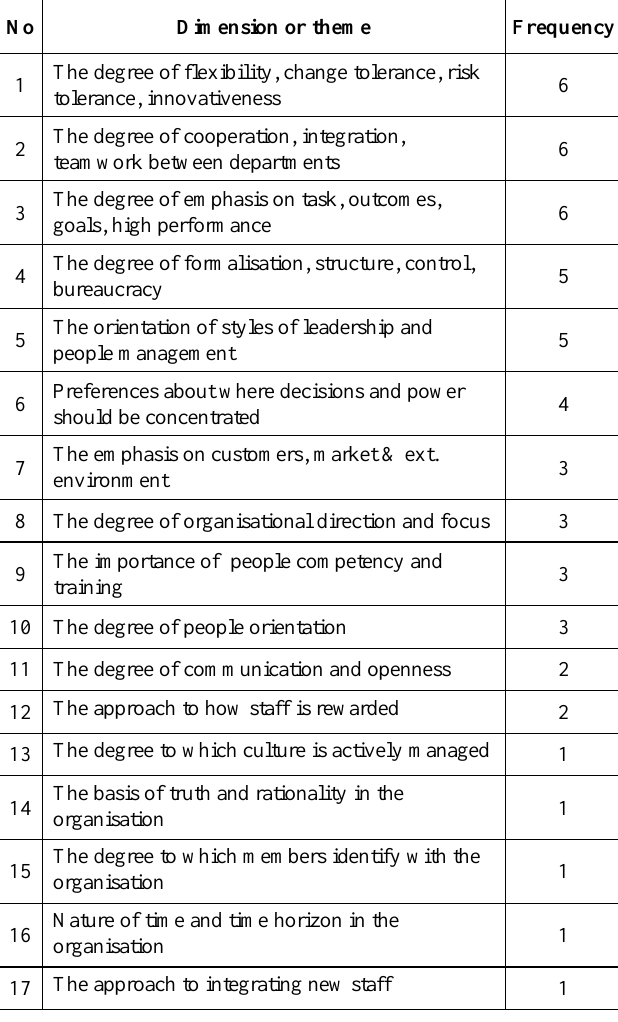
Table 1: Culture dimensions revealed by the